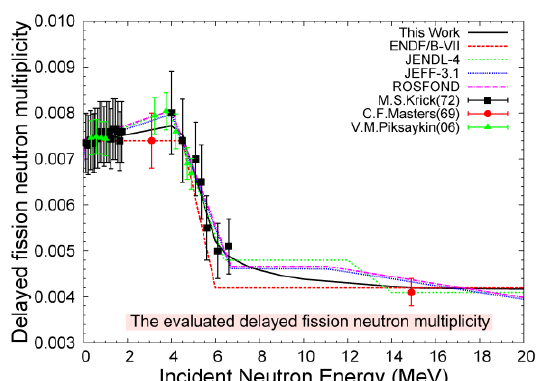
Fig. 16 . The comparison of the modified delayed fission neutron multiplicity for 233 U in CENDL-3.2 and the other evaluated and the experimental data [13].